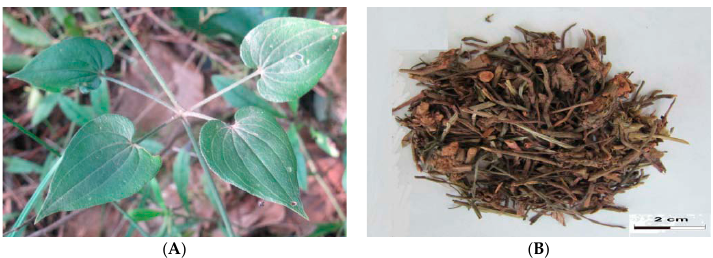
Figure 1. Rubia cordifolia Linn ( A ) and Rubiae Radix et Rhizoma ( B ).